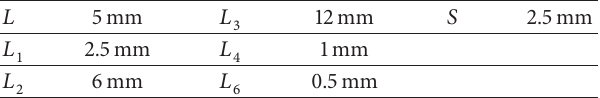
Table 1: Dimensions of single metamaterial antenna. Table 2: Dimensions of metamaterial MIMO